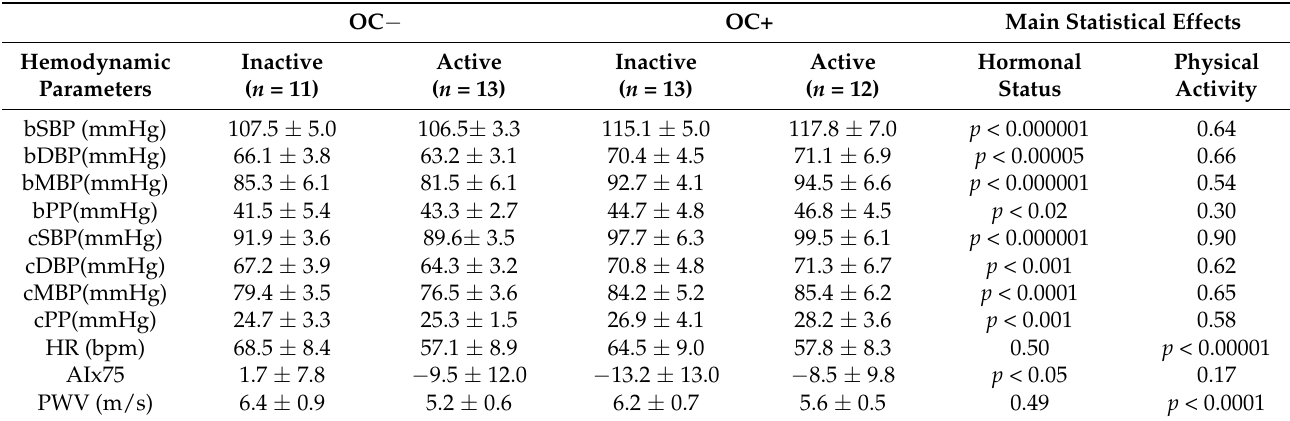
Table 2. Hemodynamic parameters.